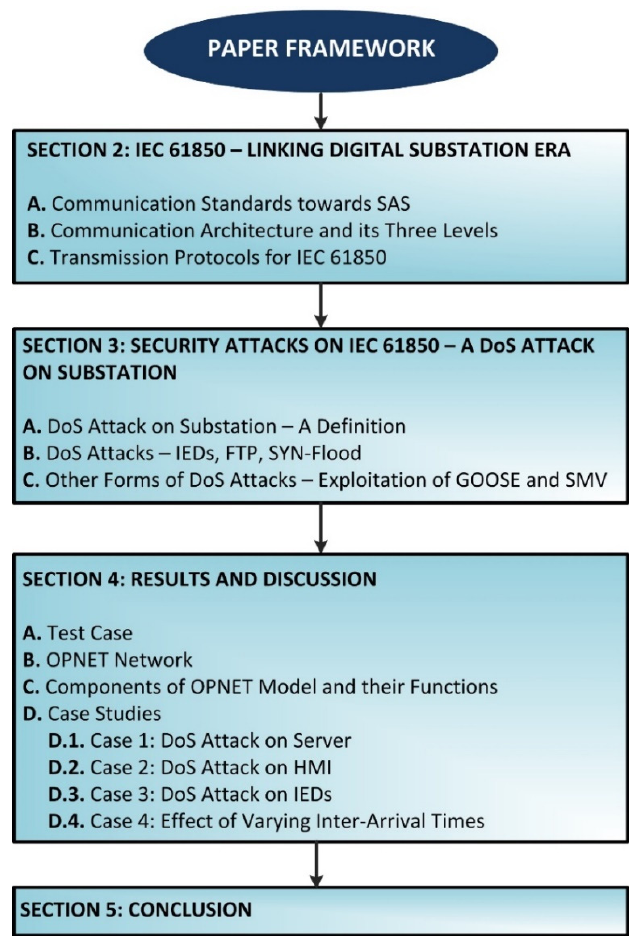
Figure 2. Framework of the paper.